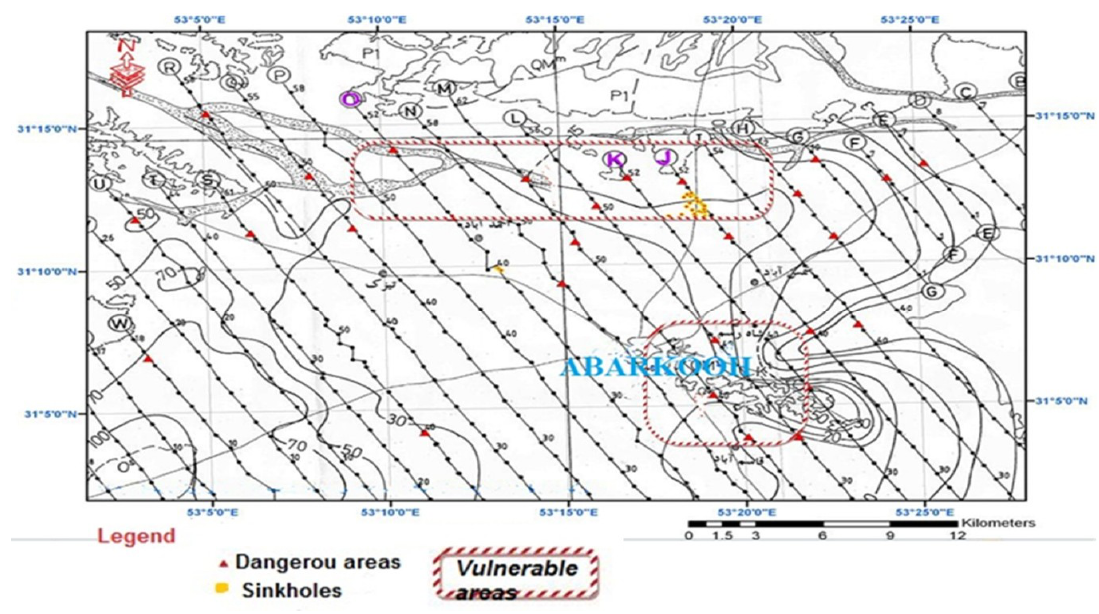
Figure 10. Geoelectrical profiles in Abarkooh plain and vulnerable areas. The sinkholes occurred between 48 and 51 points in J profile. Dangerous areas imply the potential location for occurring of the new sinkholes.